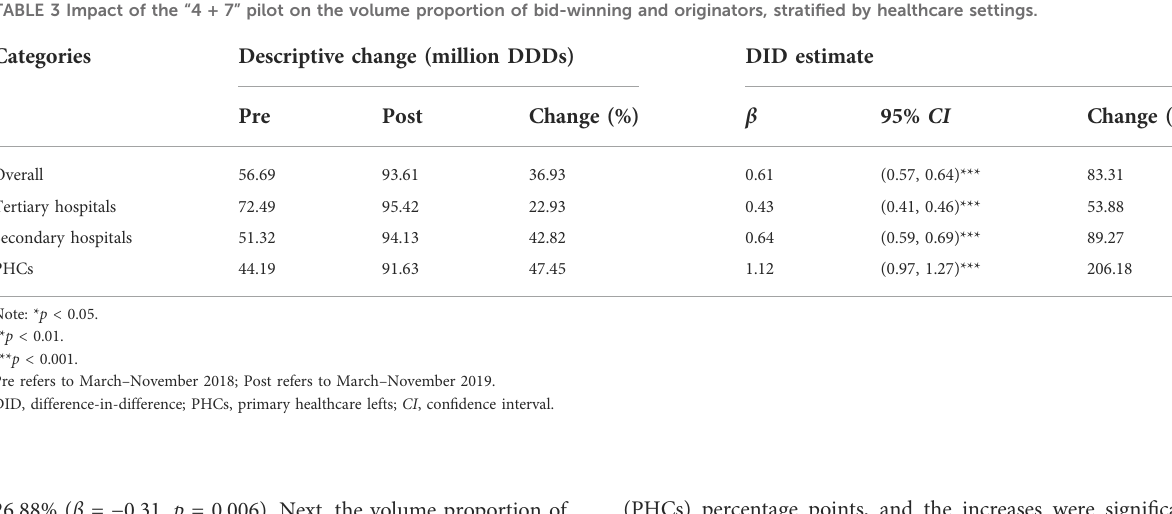
TABLE 3 Impact of the “ 4 + 7 ” pilot on the volume proportion of bid-winning and originators, strati fi ed by healthcare